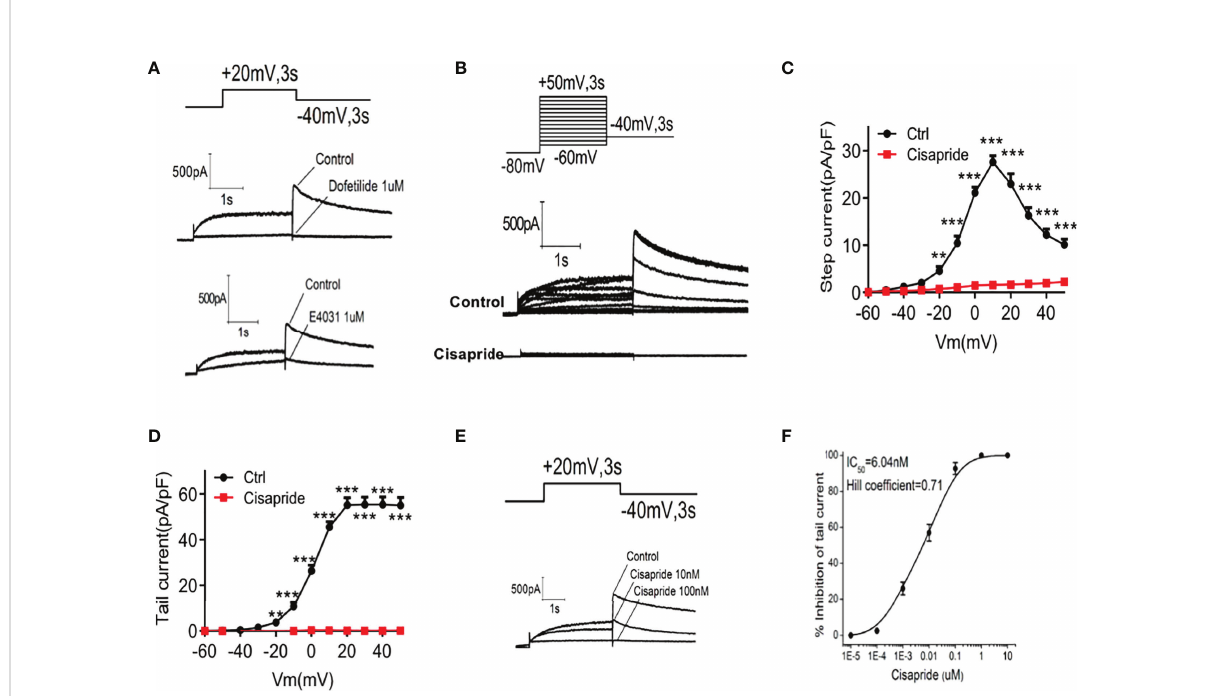
FIGURE 5 Cisapride inhibited HERG channels in transfected HEK293 cells HERG currents were recorded in transfected HEK293 cells. Cells were voltage- clamped at − 80 mV for 1 s, depolarized from − 60 mV to +50 mV for 3 s and repolarized to − 40 mV for 3 s under stimulation with (A) E4031, dofetilide or (B) cisapride. (C) The time-dependent step current and (D) peak tail current I-V curves were recorded before and after cell perfusion with 1 ?mol/L cisapride. (E) Cells were depolarized to a voltage of +20 mV for 3 s using a stepped procedure. Peak tail currents were recorded at different cisapride concentrations (10 and 100 nmol/L). (F) The IC50 of cisapride was calculated. The concentration − response curve was fi tted to a Hill equation. n=4 for each group (A – F) . ** P < 0.01, *** P < 0.005 vs.